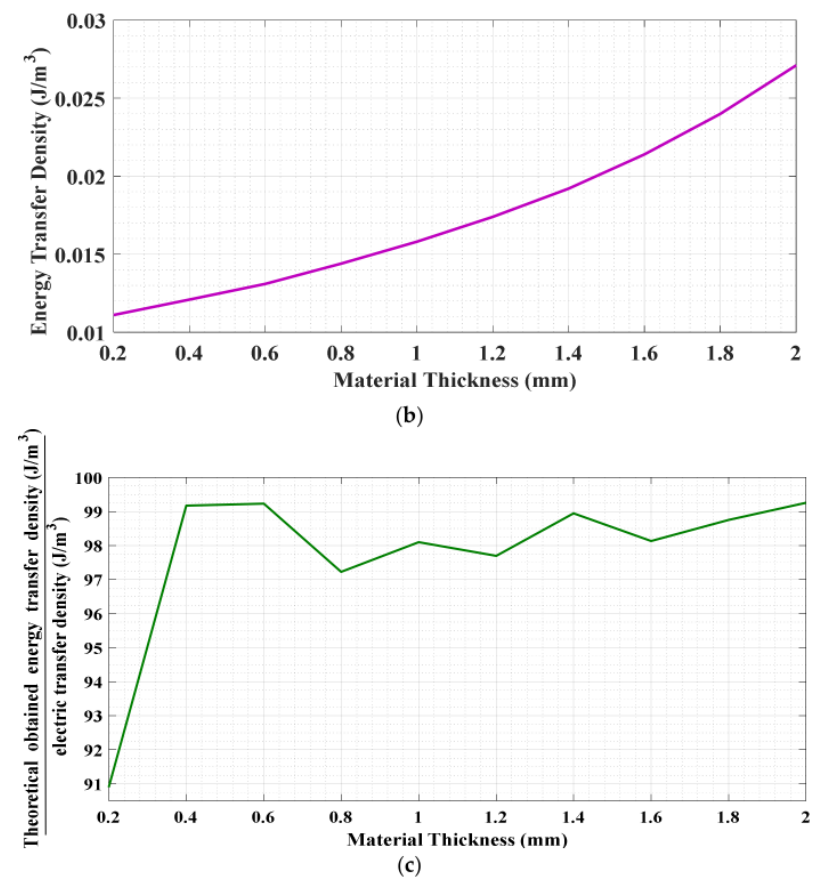
Figure 19. ( a ) Variation of capacitance due to ceramic coating on both plates. ( b ) Variation of energy transfer density due to ceramic coating on both plates. ( c ) Variation of ratio% (theoretical obtained energy transfer density by actual electric transfer density) due to ceramic coating on both plates.